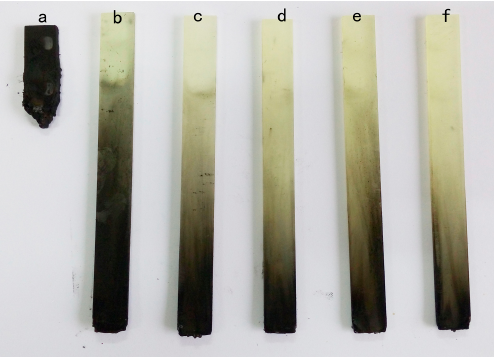
Figure 2. Digital photos of ( a ) EP-0; ( b ) EP-0.5; ( c ) EP-1; ( d ) EP-1.5; ( e ) EP-2; and ( f ) EP-2.5 samples after UL-94 test.